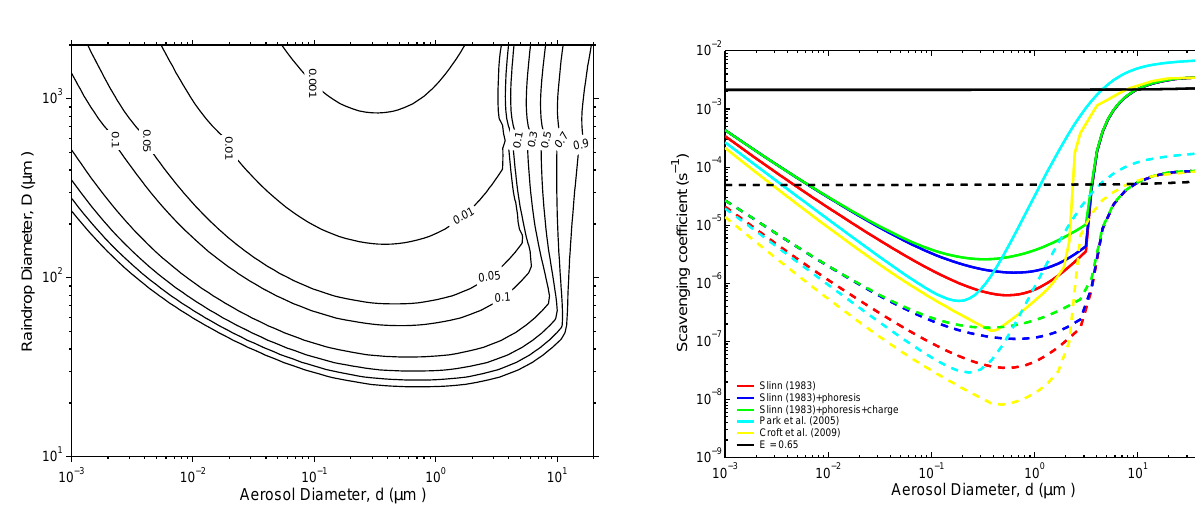
Fig. 2. Total collection efficiency E(d p ,D p ) (contoured) taking into account the contributions of all of the processes shown in Fig. 1 as a function of both particle diameter and raindrop diameter.